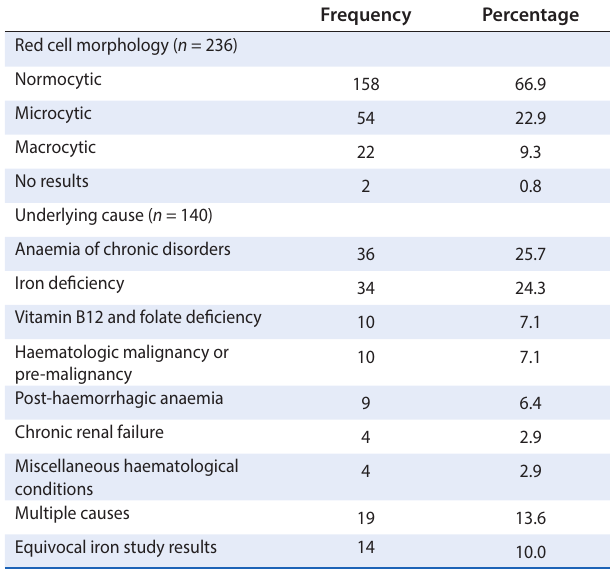
Table 1: Red cell morphology and cause of anaemia in elderly hospitalised